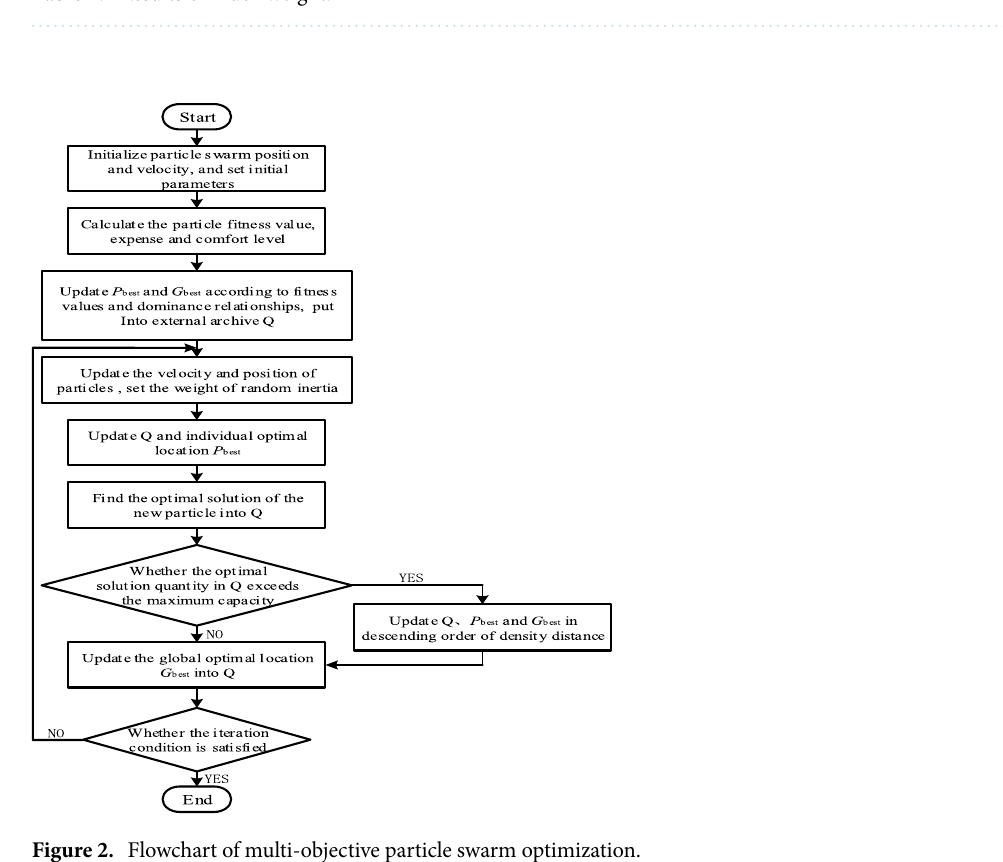
Table 2. Results of index weight.